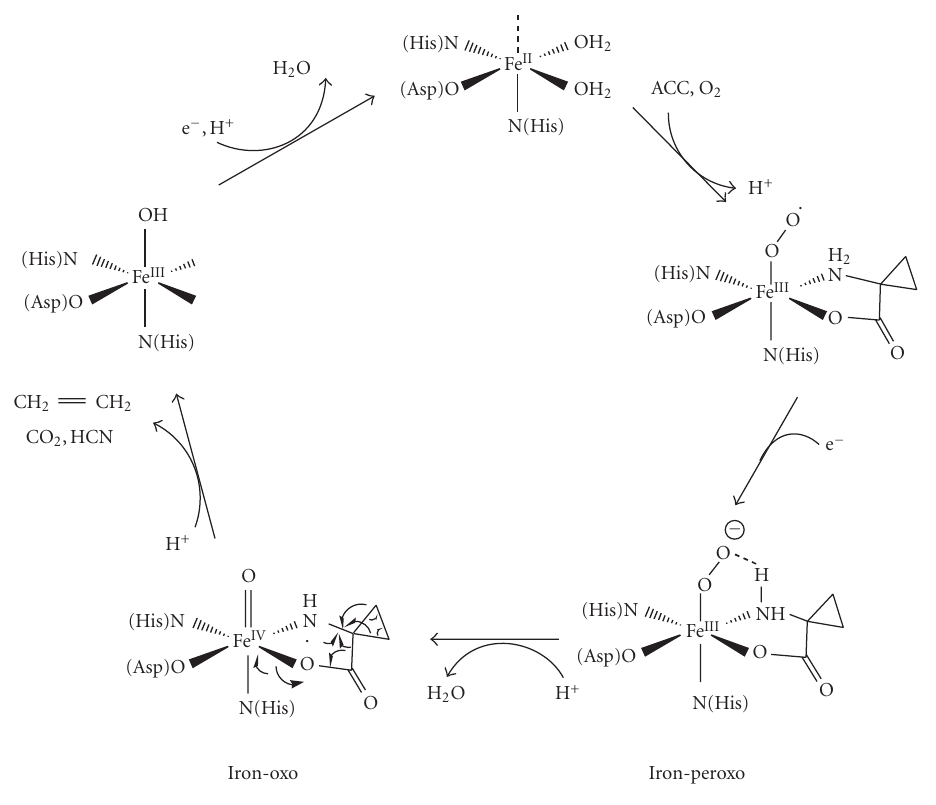
Scheme 2: Possible catalytic mechanism for